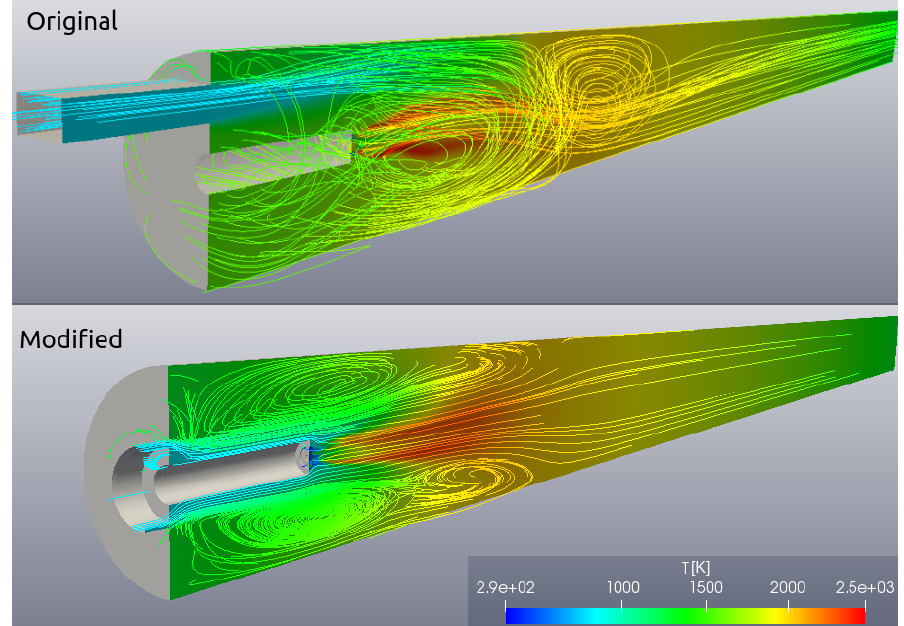
Figure 6. Computed streamlines colored with temperature values in K for the original rectangular ( top ) and modified annular ( bottom ) secondary air inlet. For both cases, a hot zone due to the flame and the recirculation due to the secondary air can be seen.